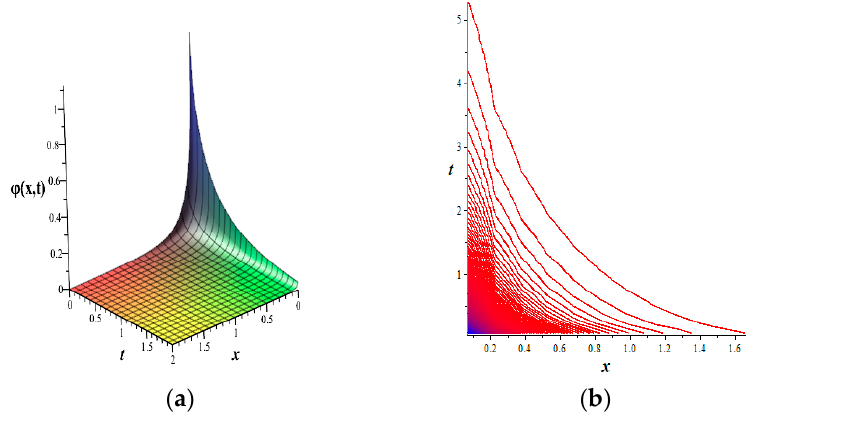
Figure 3. ( a – c ) Characterize the wave via ),( tx ====== BAvkk α 8.0,1,2,1,5.0,5.0 21